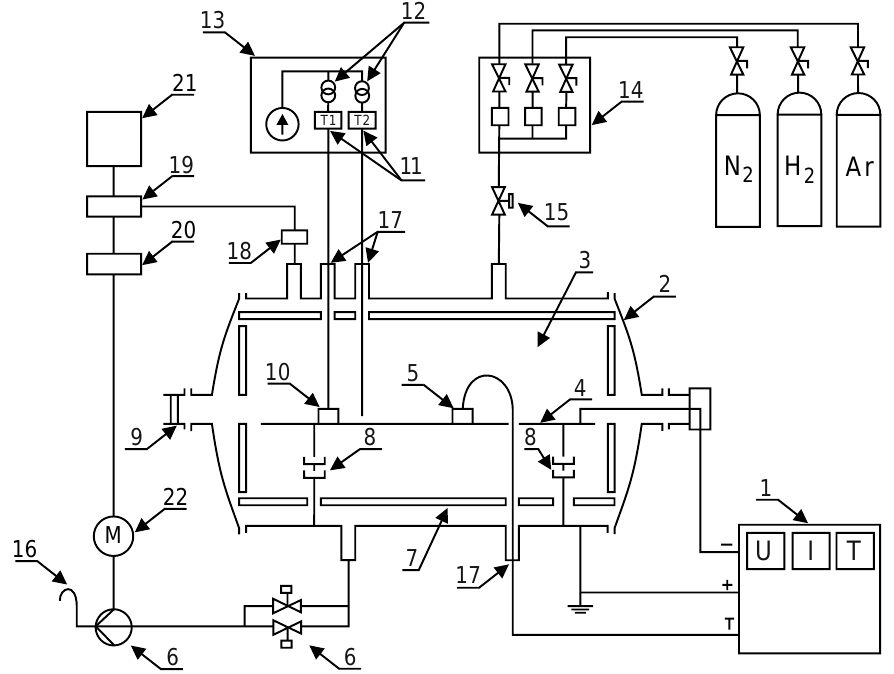
Figure 2. The schematic diagram of the glow discharge nitriding device: 1—MSS10 power supply, 2—water-cooled anode, 3—glow zone, 4—cathode, 5—temperature measurement sensors, 6—valve assembly and vacuum pump, 7—insulating screen, 8—insulators, 9—sight glass, 10—machined elements, 11—thermocouples, 12—transformers, 13—insulating casing of the temperature measuring system, 14—mass flow meters (gas dosing system), 15—electrovalve, 16—gas outlet, 17—insulation bushings, 18—measuring head, 19—vacuum gauge, 20—inverter, 21—computer, 22—rotary vacuum pump motor.